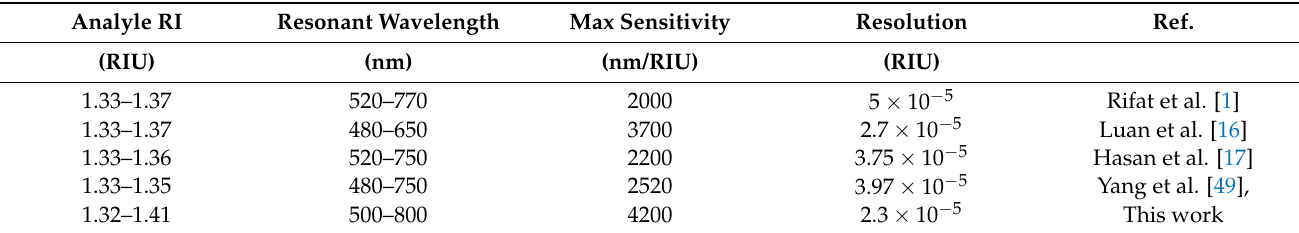
Table 3. Performance